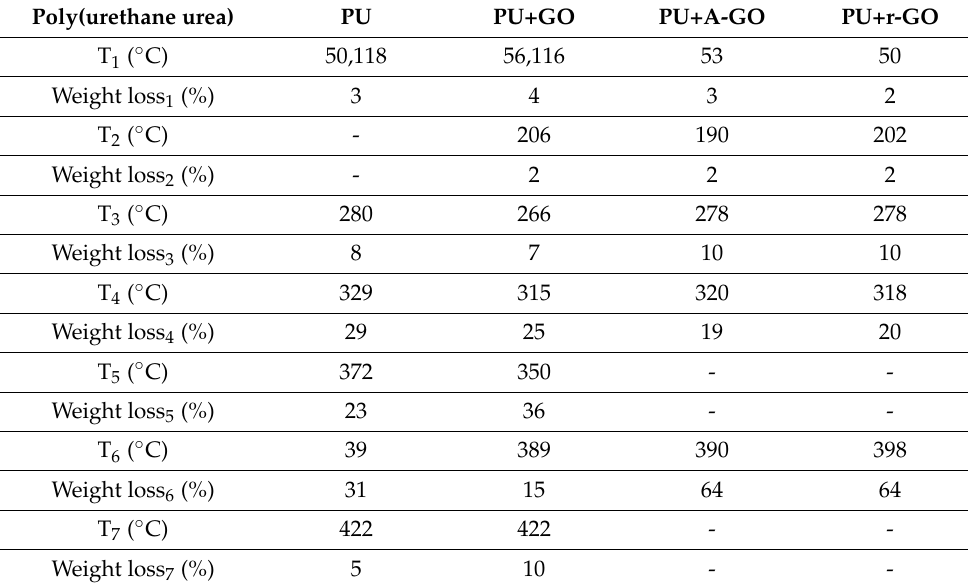
Table 9. Values of the temperatures and the weight losses of the thermal decompositions of the PUs. At the end of TGA experiment, all PUs exhibit a residue of 1